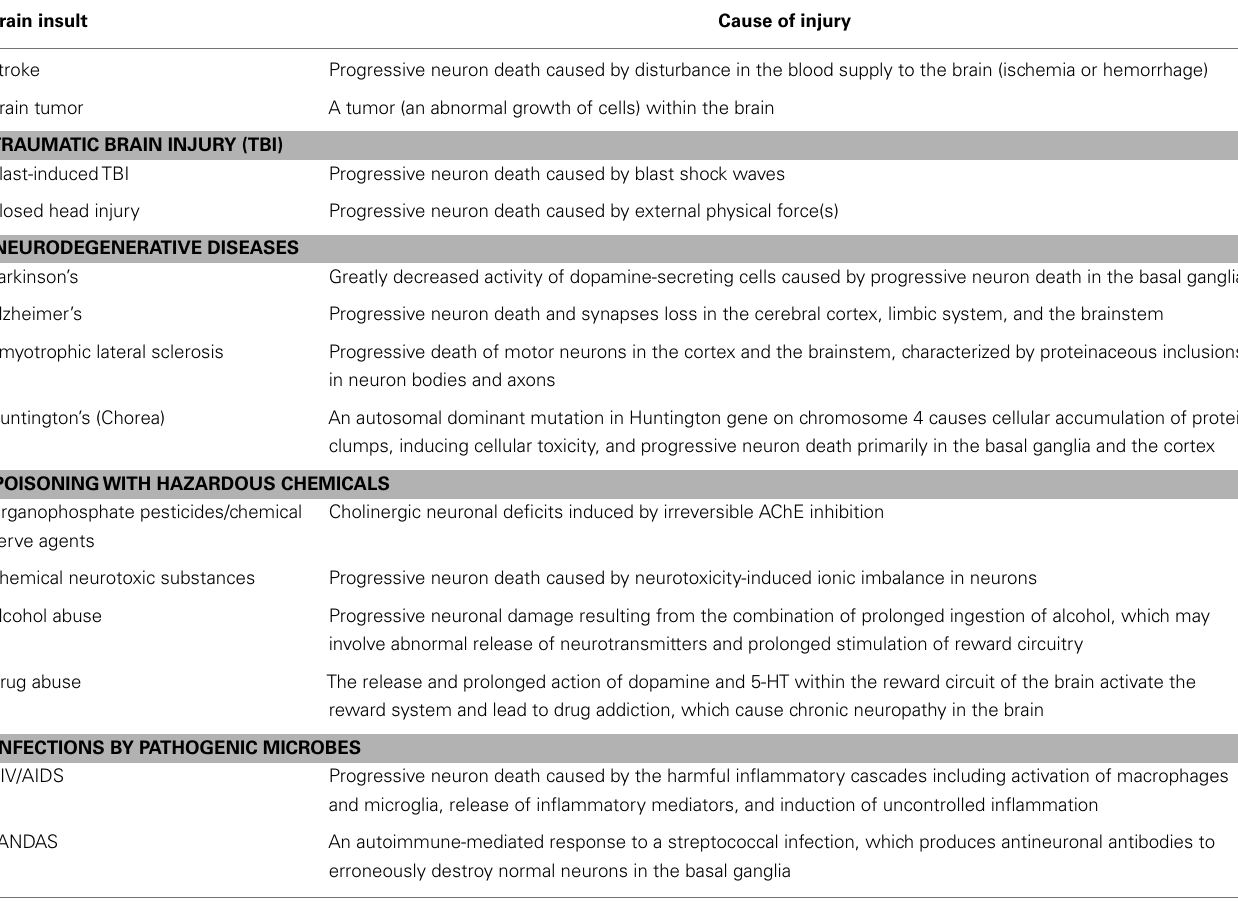
Table 1 |The initial causes of brain